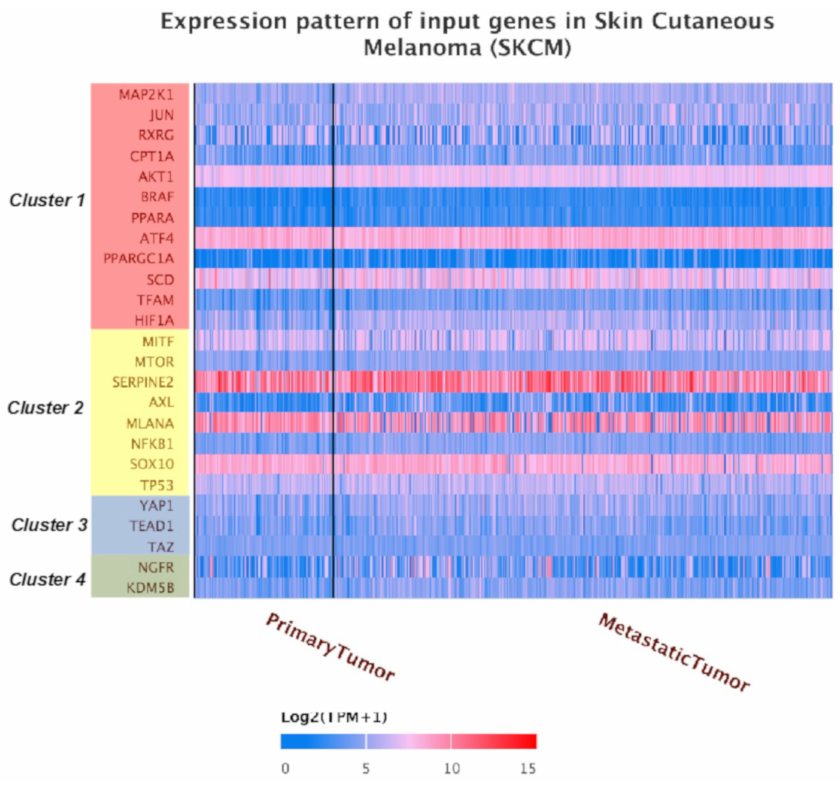
Figure 3. Expression levels of the 25 top genes relevant for melanoma CSCs and resistance to target therapy on 480 samples of skin cutaneous melanoma from The Cancer Genome Atlas. http: // ualcan.path.uab.edu /